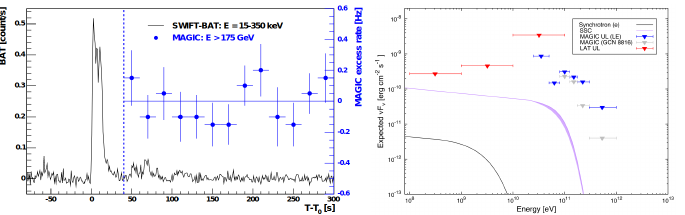
Figure 5. ( Left ) MAGIC excess event rate above the energy threshold of 175 GeV compared with the Swift -BAT light curve for GRB 050713A, the first prompt emission followed by an IACT. The vertical line shows the beginning of observations with the MAGIC telescope. Reprinted with permission from Ref. [65]. ( Right ) MAGIC and Fermi -LAT overlapping upper limits for GRB 090102. These results are compared to a leptonic synchrotron+SSC afterglow model. From model and data analysis described in [5].